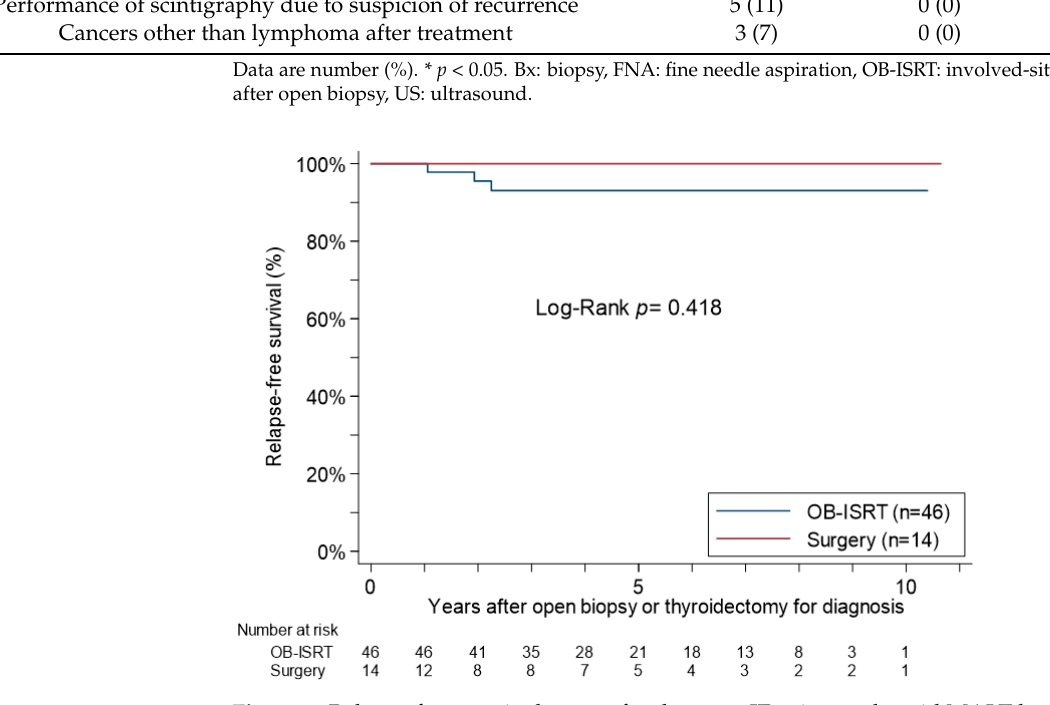
Figure 3. Relapse-free survival curves for the stage IE primary thyroid MALT lymphoma patients who underwent OB-ISRT and those who underwent Surgery after an open biopsy or thyroidectomy.